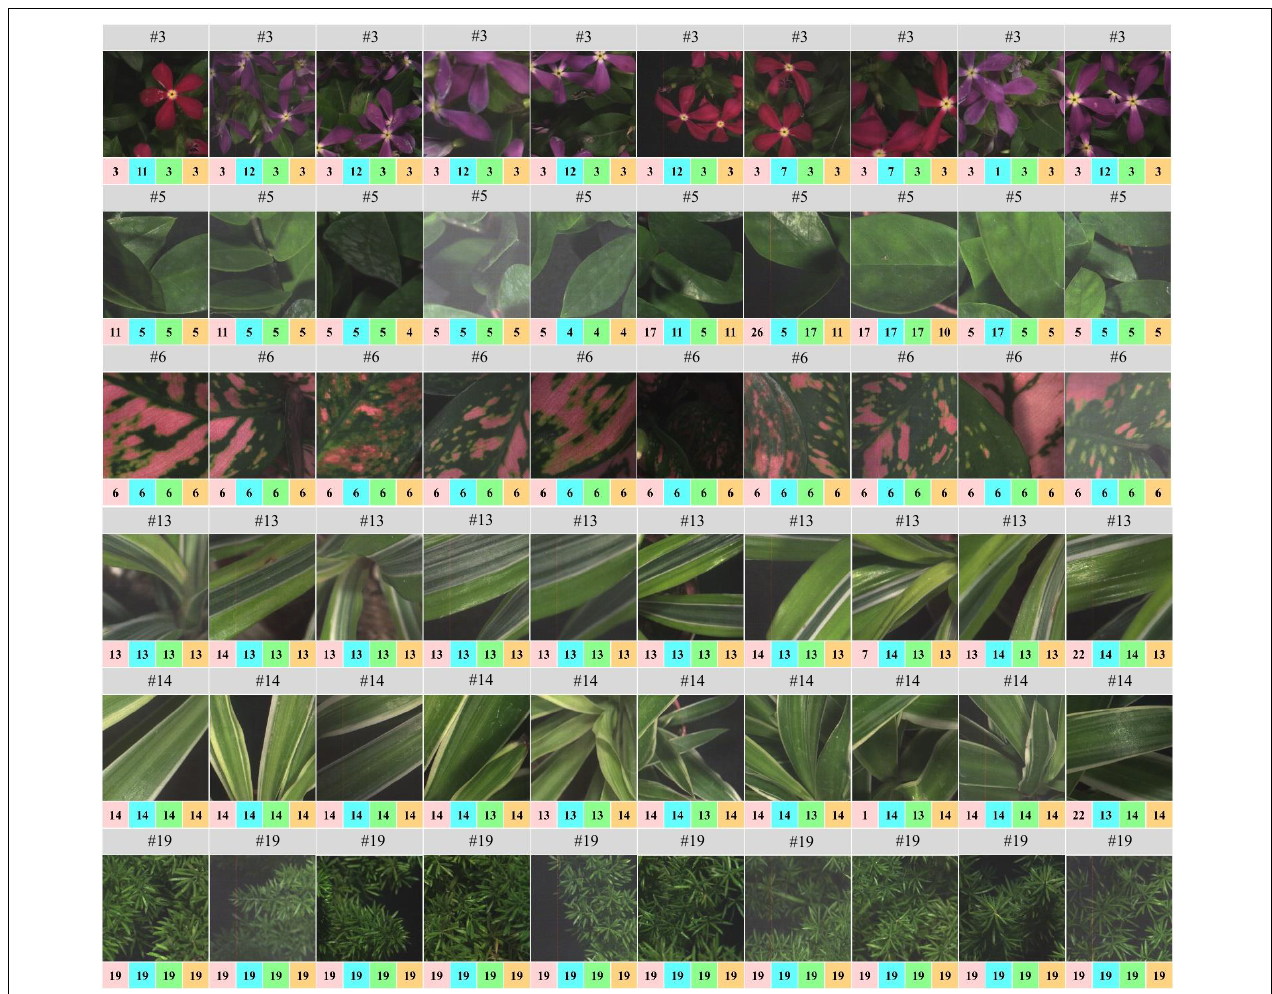
FIGURE 10 | An illustration of species classification by the four CNN models. Species #13 and #14 whose images are entirely recognized by the LtCNN model but eventually misclassified by the other models. The number above each image is the species identity, and the number highlighted by a color box indicates the classified label of the species by the models. Please refer to Figure 8 for the color